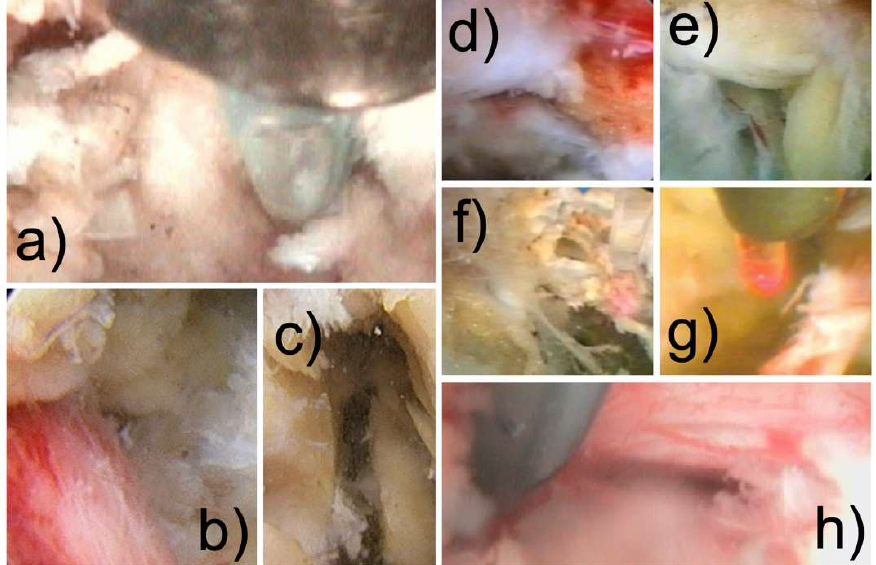
Figure 1. Examples of directly visualized pain generators identified with the spinal endoscope that are often missed by routine lumbar MRI scans include herniated or inflamed disc herniation ( a ), an inflamed nerve ( b ), a superior foraminal facet osteophyte, a vacuum disc with delaminated devitalized disc tissue ( c ), a hypertrophied superior articular process (SAP) with a facet cysts and tender capsule, an impacting facet margin ( d ), a furcal nerve ( e ), a tethered nerve root with contracted scar tissue from the pars inter-articularis ( f ), a hypervascular scar on the exiting nerve root ( g ), and a hypervascular in-flamed traversing nerve root ( h